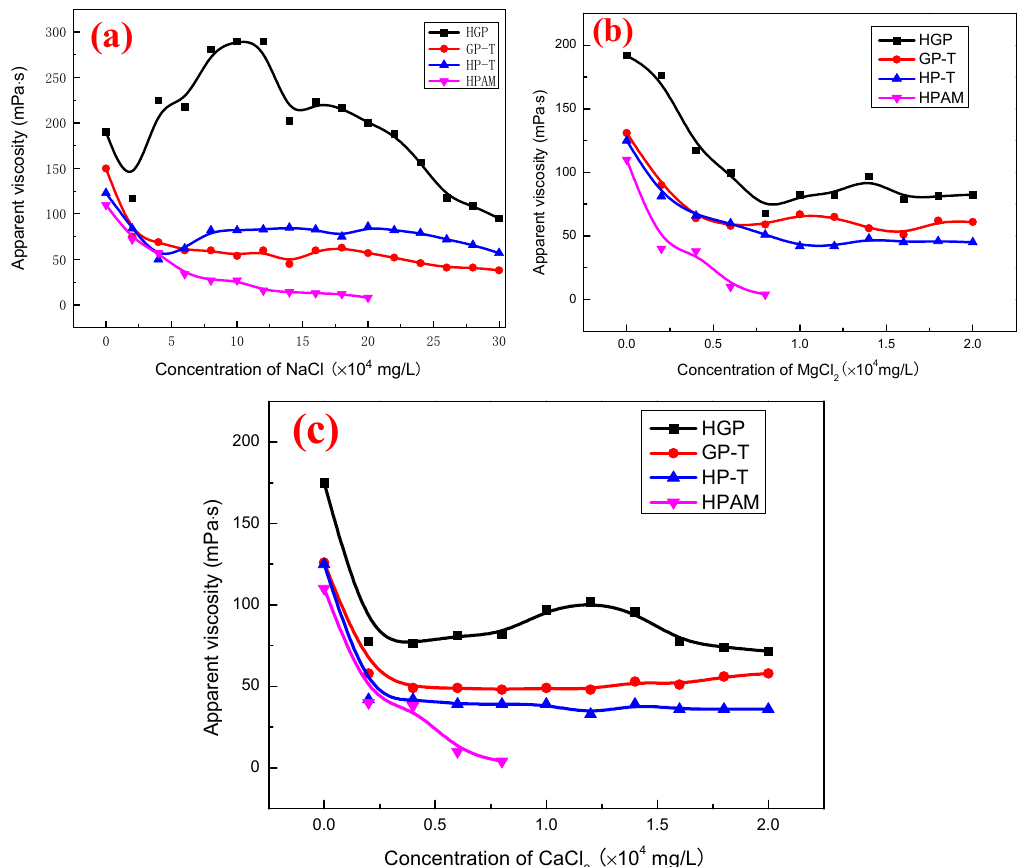
Figure 14. Effects of inorganic salt concentrations on the viscosities of HGP, GP-T, HP-T, and HPAM, 0.6 wt.%. ( a ) NaCl, ( b ) MgCl 2 , ( c ) CaCl 2 .